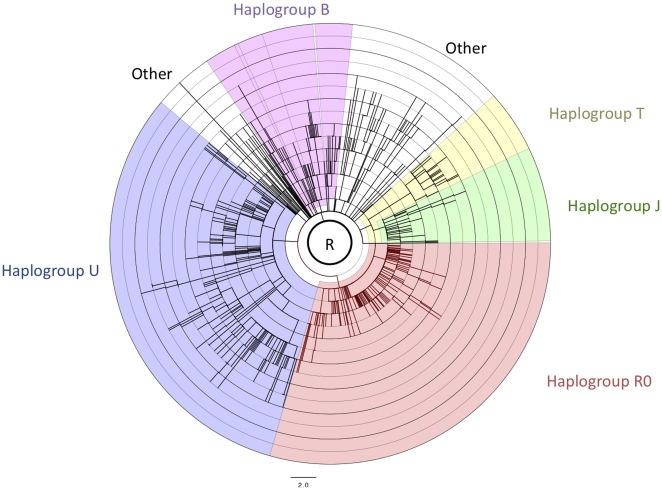
Schematic phylogeny of the R haplogroup.The data and tree topology are based on the PhyloTree dataset and branch lengths reflect the differential accumulation of mutations along different lineages.